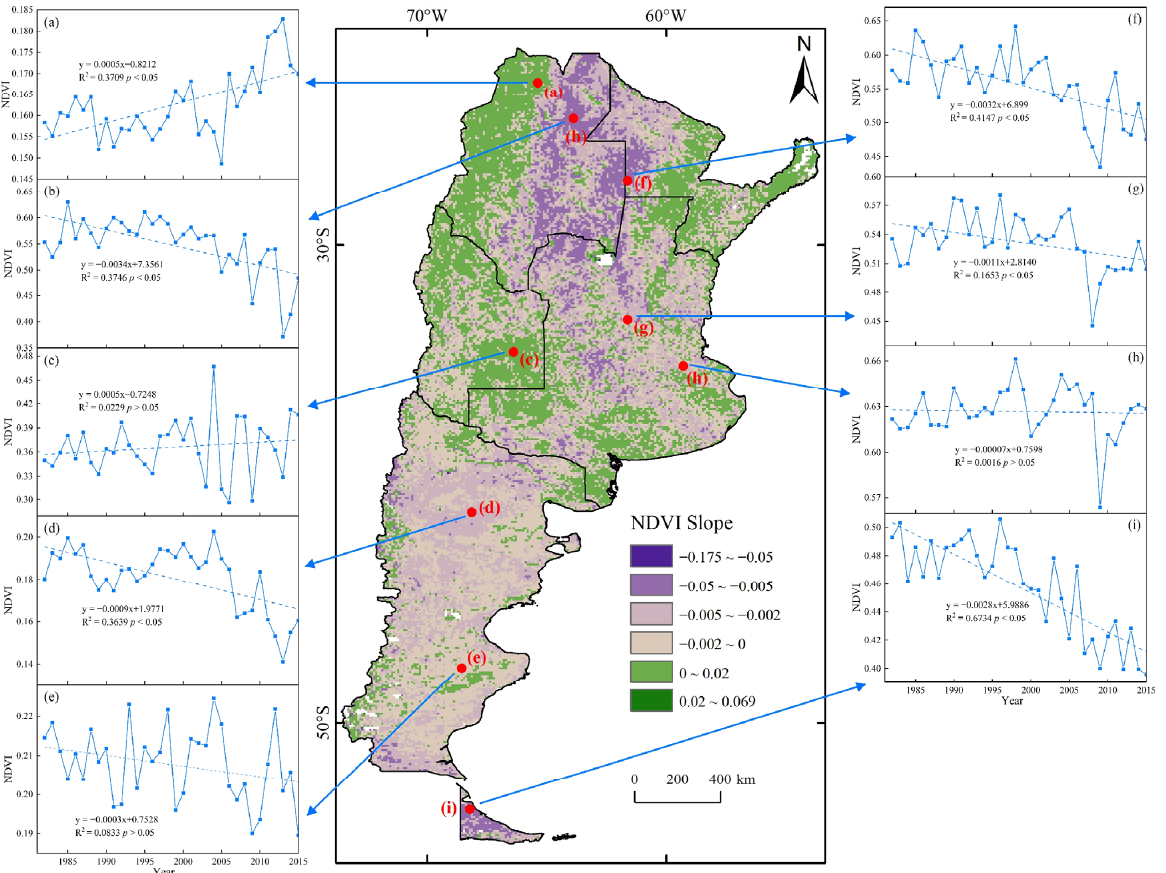
Figure 5. NDVI time series sample at individual pixels in Argentina from 1982 to 2015. ( a – i ) are the time series of selected sample pixels from 1982 to 2015.